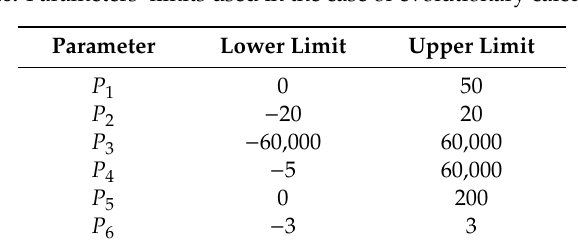
Table 26. Parameters’ limits used in the case of evolutionary